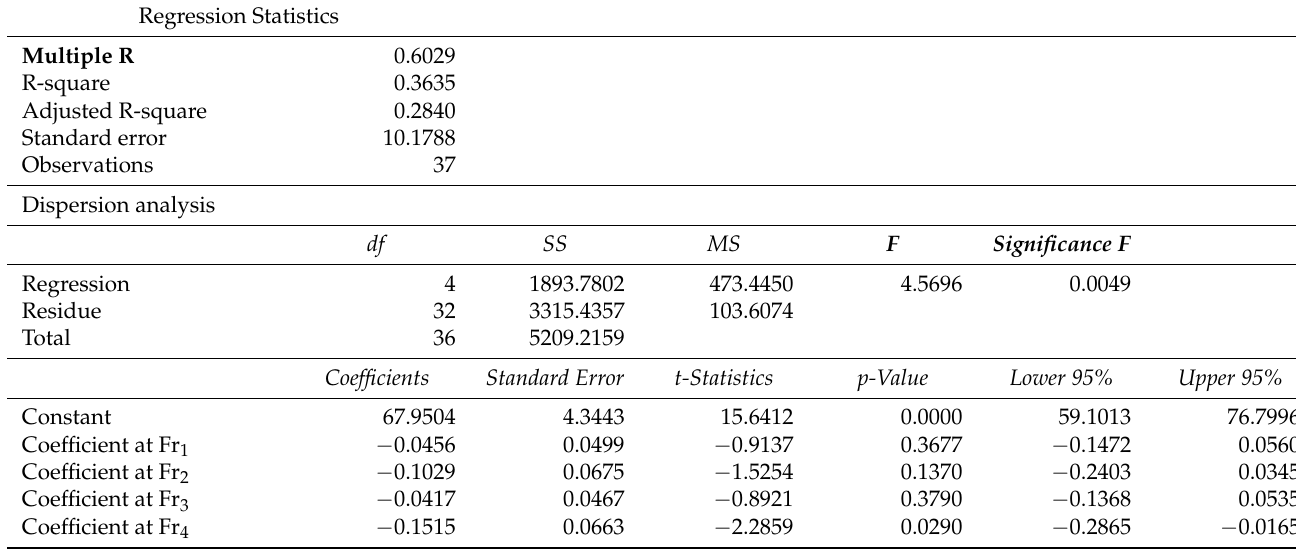
Table 4. Dataset modelling of the impact of the standard financial factors of commercial entrepreneurship on social